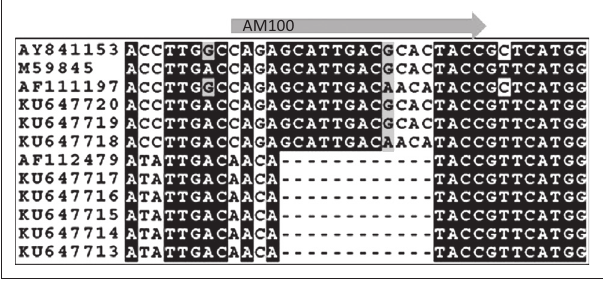
FIGURE 5: Alignment of South African Anaplasma marginale msp1 β sequences generated in this study (KU647713–KU64747420) with published Anaplasma